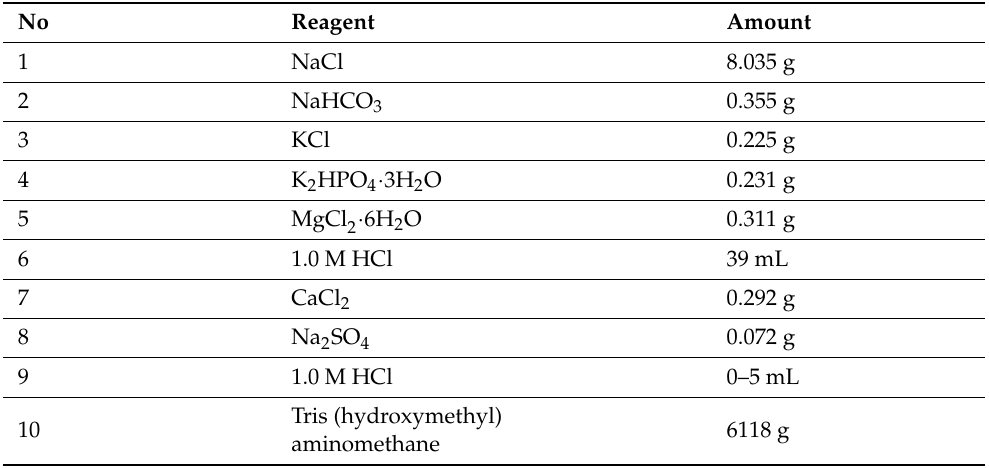
Table 1. Amount of regent for preparing 1000 mL of SBF